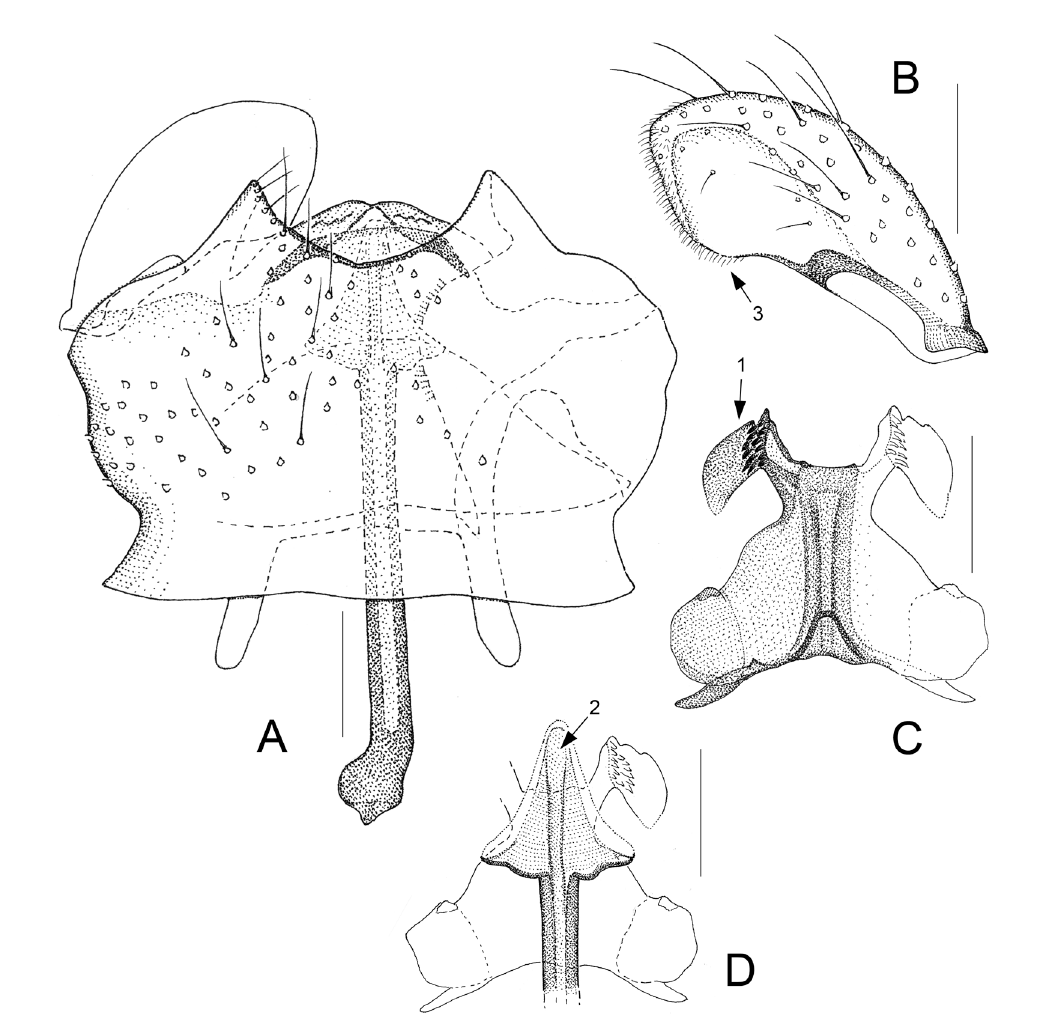
Fig. 20. Glemparon warra sp. nov., holotype, ♂ (AM, no. CEC1408). A . Genitalia, ventral. B . Gonostylus, ventral. C . Tegmen, ventral. D . Apex of ejaculatory apodeme, tegmen indicated, ventral. Scale bars = 0.05 mm. Numbered arrows indicate diagnostic characters (see